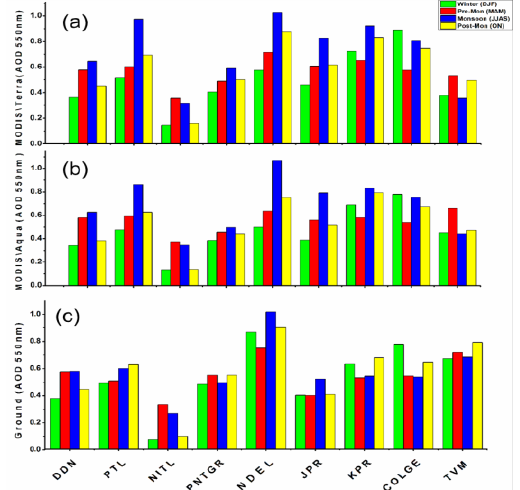
Figure 3. Climatological (2001-2017) seasonal variation of AOD at 550nm (a) Terra , (b) Aqua and (c) ground measured at different locations over India.